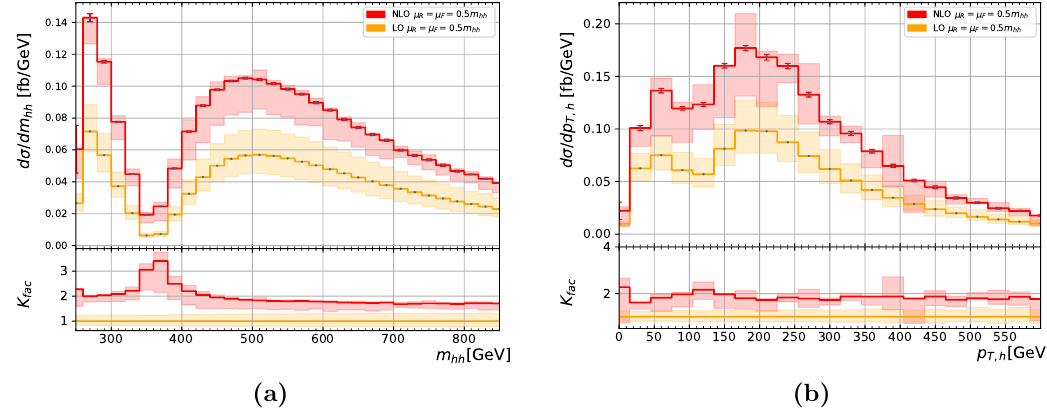
Figure 25. Scale variations for benchmark point